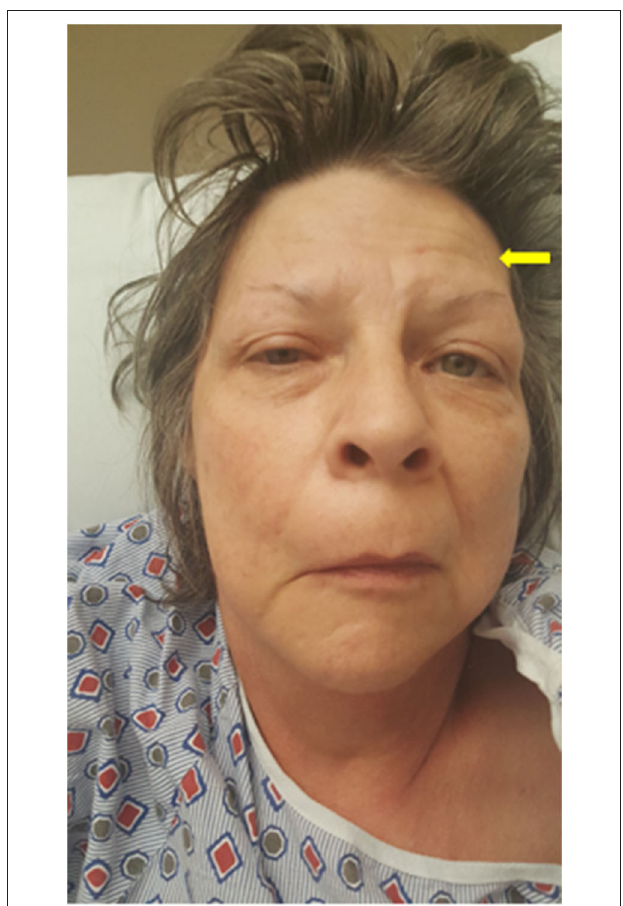
FIGURE 1 | Myasthenia gravis masking as unilateral facial palsy. Image of the patient showing a right facial droop, mild right eye ptosis, and an unfurrowed right forehead. The yellow arrow points to the frontalis sign, suggesting that she is using her (partially weakened) frontalis muscle to overcome the ptosis.